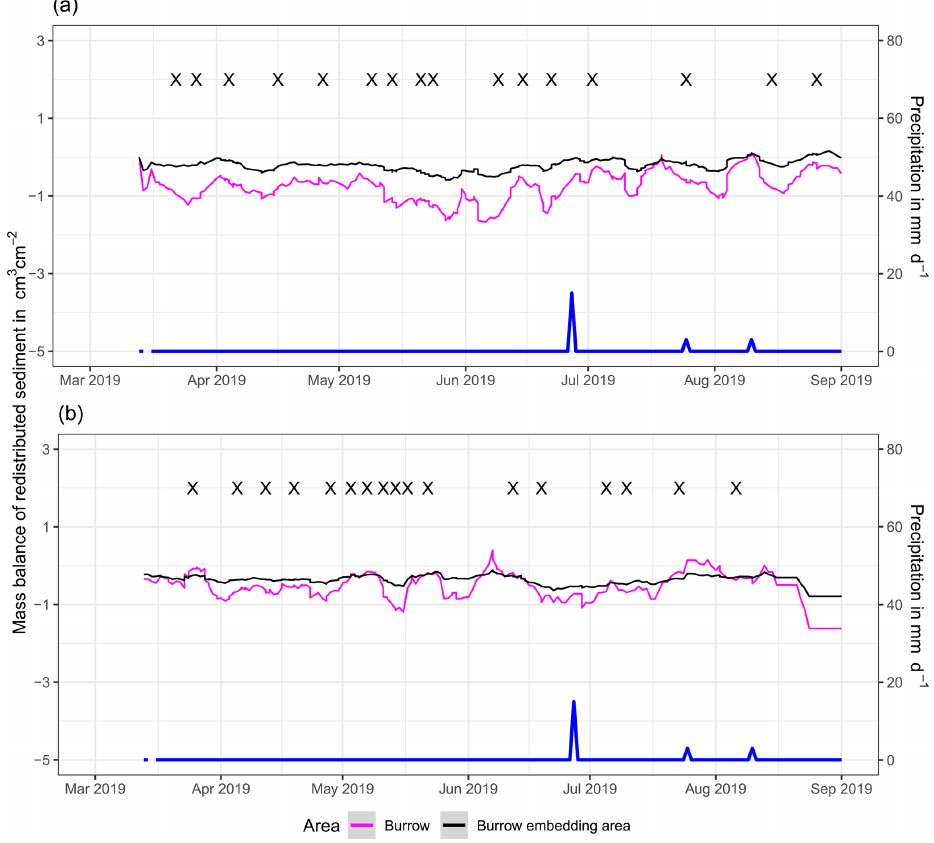
Figure 5. Examples of the mass balance of redistributed sediment for burrows and burrow-embedded areas. (a) The record of the camera on the north-facing upper hillslope at La Campana showed that larger rainfall events cause a negative sediment balance (sediment loss), followed by a phase of positive sediment mass balance after approximately 3d due to sediment excavation; (b) The record of the camera on the north-facing upper hillslope in Pan de Azúcar showed a similar pattern to the camera on the north-facing upper hillslope, but the phase of positive mass balance was delayed in comparison. The blue line is the daily precipitation (in mmd − 1 ), and “X” marks the days at which animal burrowing activity was detected. Positive values indicate sediment accumulation. Negative values indicate sediment erosion. Mass balances for all cameras are displayed in Figs. A2 and